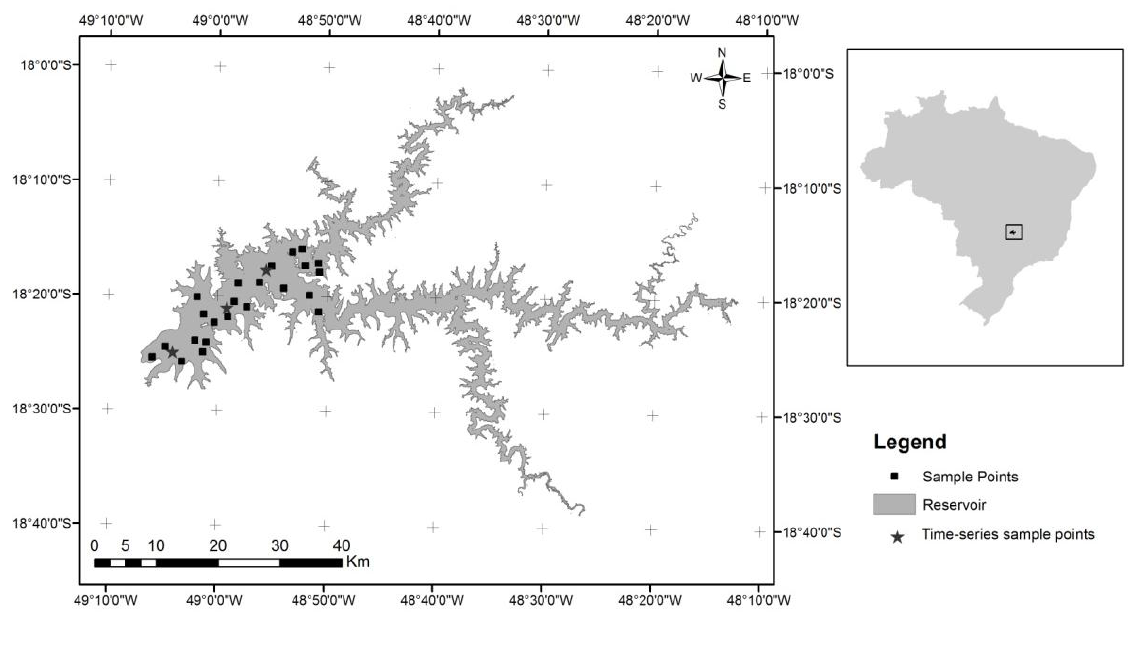
Figure 1. Location and sampling sites in the Itumbiara